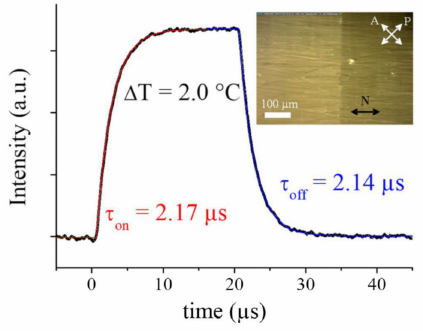
Figure 5. ECE NTB response (black open symbols) to a square dc pulse (15 V/ µ m, 20 µ s) measured in a BNA76 monochiral domain. The solid lines are the best fit of the data with an exponential law for the rise (red) and the fall (blue) of the response. The inset shows two large monochiral uniform domains of opposite chirality observed with slightly uncrossed polarizers.